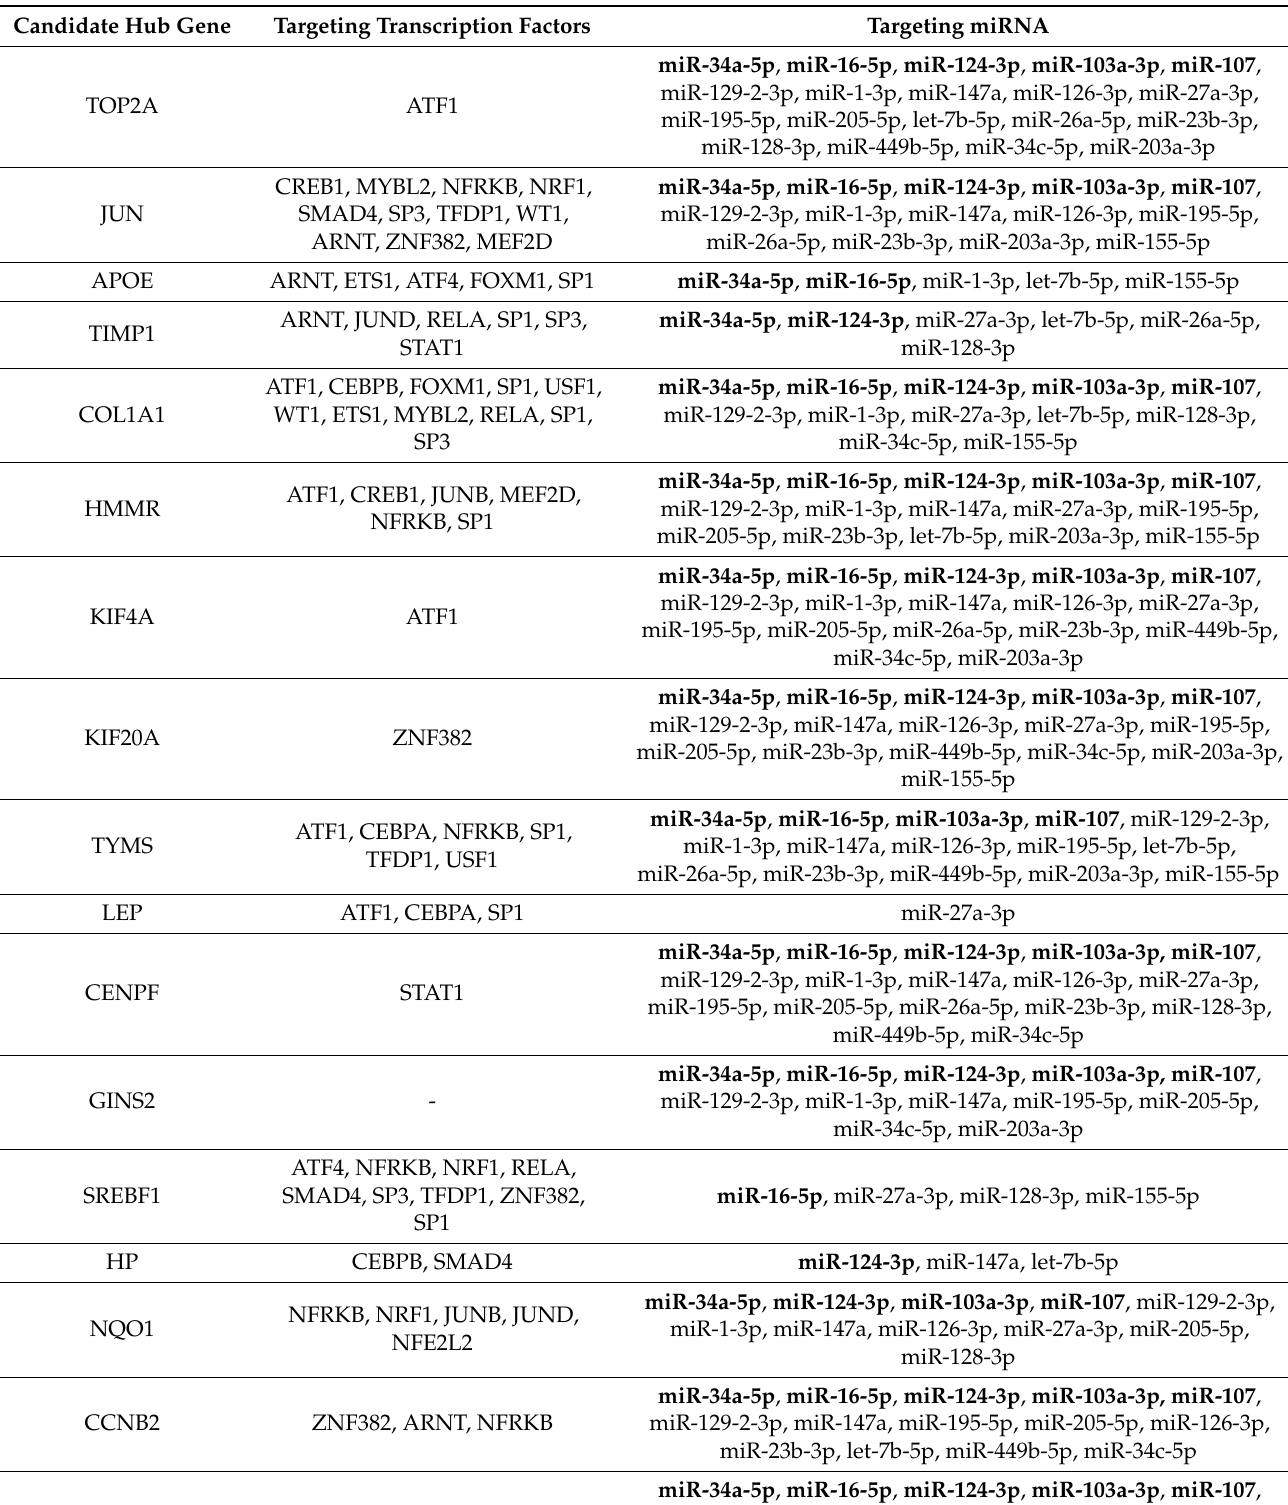
Table 2. Candidate hub genes with targeting transcription factors and